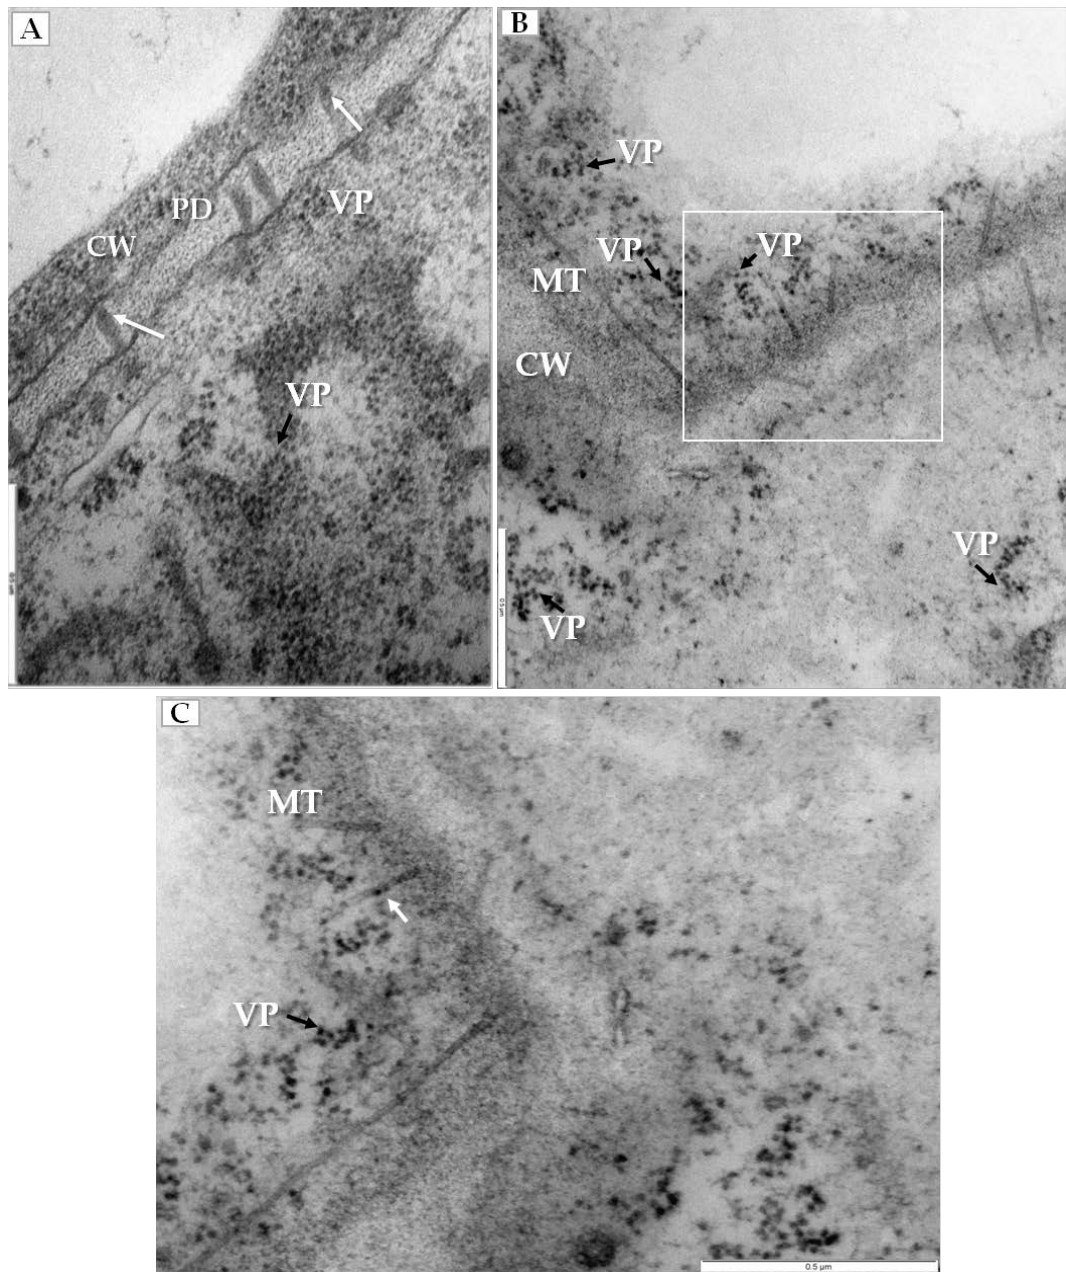
Figure 5. Changes in plasmodesmata in PDV-infected cucumber leaf. ( A ) Section of mesophyll cell with extended plasmodesmata and viral particles (VP, black arrow). Viral particles present inside plasmodesmata and indicated with a white arrow, Bar 0.5 µm; ( B ) Fragment of mesophyll cell containing viral particles (VP, black arrow) near tubular structures induced by PDV-MP. The white frame area is presented in ( C ), Bar 0.5 µm; ( C ) This enlarged fragment of infected mesophyll cell shows viral particles inside tubular structures induced by PDV MP (white arrow). Viral particles (VP) in cytoplasm near plasmodesmata are marked with black arrow, Bar 0.5 µm. Abbreviations: CW—cell wall, PD—plasmodesmata, MT—movement protein induced tubular structures, VP, black arrow—viral particles.